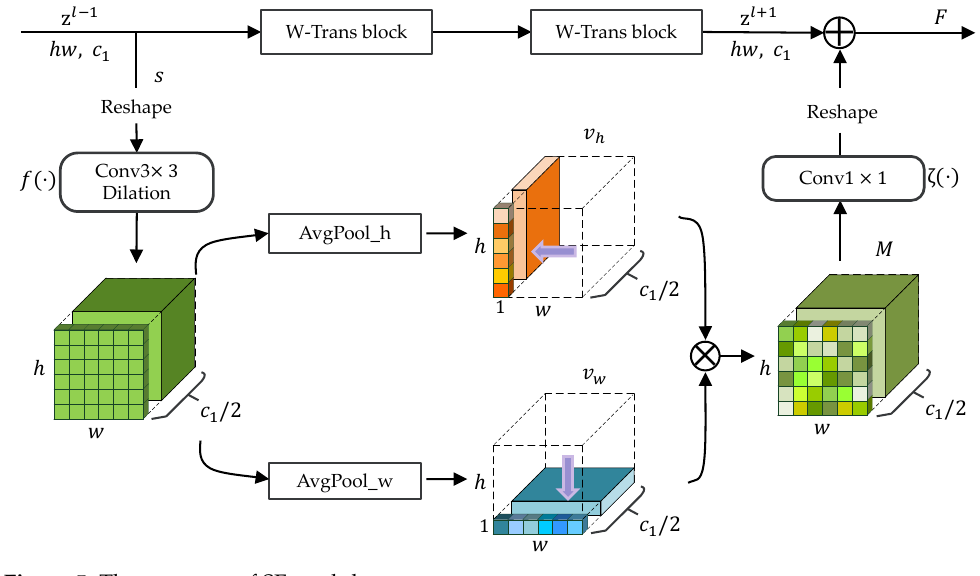
Figure 5. The structure of SF